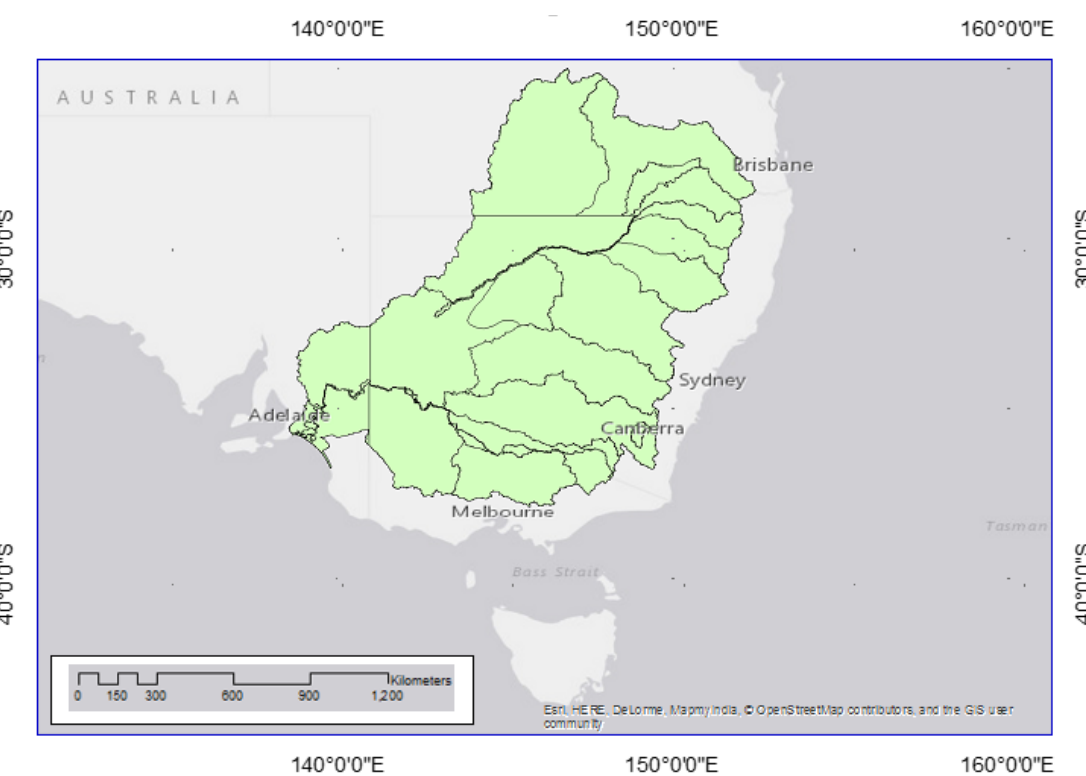
Figure 1. The Murray Darling Basin, which consumes about 70% of the water abstracted for irrigation in Australia.